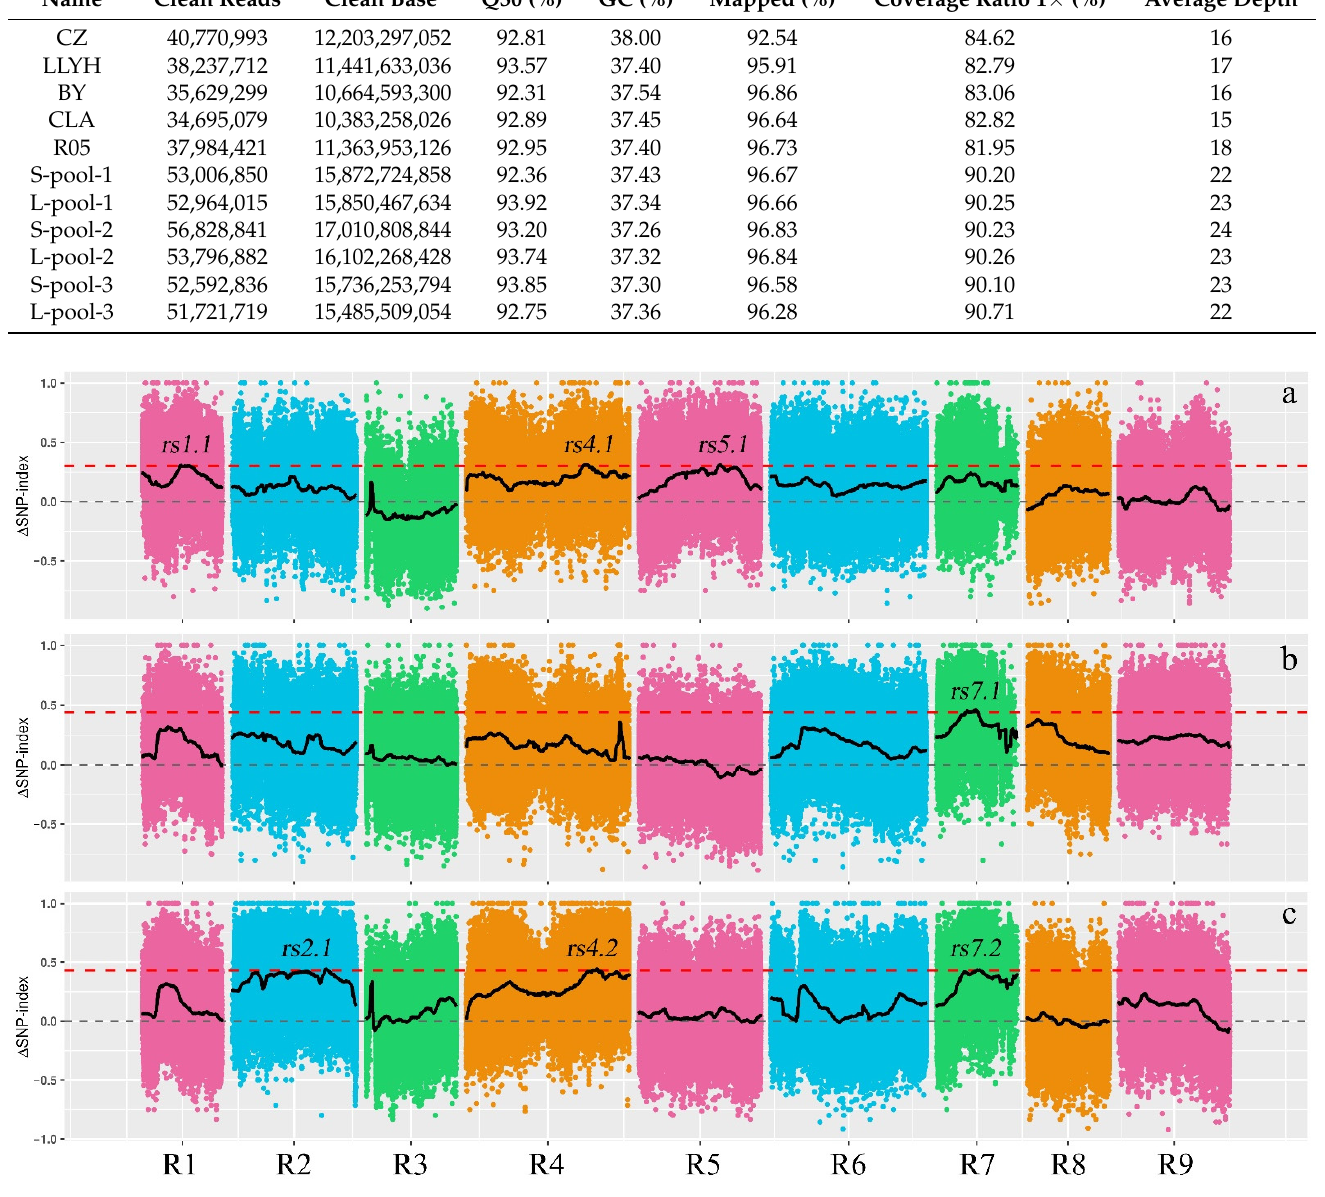
Figure 3. The ∆ (SNP index) distribution of the QTLs for the root shape index detected by QTL-seq. ( a ) The ∆ (SNP index) distribution of the 1902 population. ( b ) The ∆ (SNP index) distribution of the 1908 population. ( c ) The ∆ (SNP index) distribution of the 1909 population. The red lines represent the threshold lines with confidence of 0.99. Table 4. Summary of QTLs detected for the root shape index with